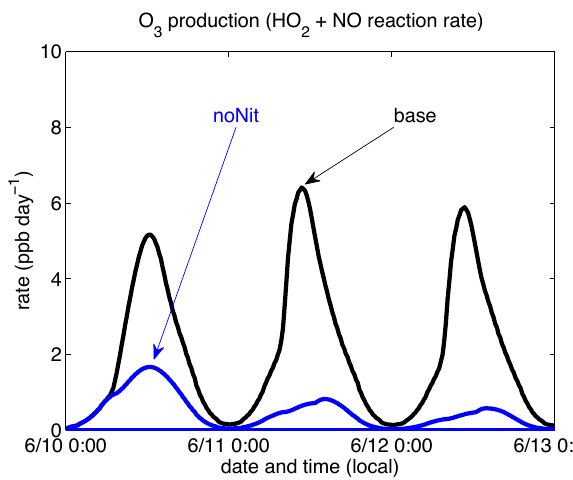
Fig. 7. Ozone production from NO to NO 2 conversion reaction (R8). The average ozone production rate from snow sourced NO x results in an additional 2ppb of O 3 in the boundary layer at